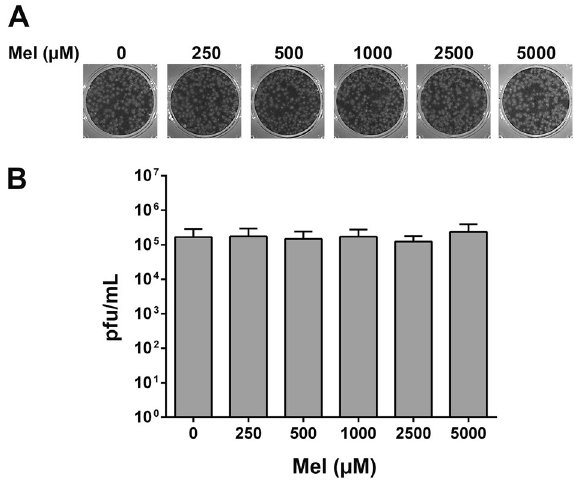
Figure 2. Analysis of the direct virucidal activity of melatonin (Mel) against Japanese encephalitis virus (JEV). ( A ) JEV was incubated with melatonin at various concentrations for 2 h, and the viral titer was determined by plaque assay and expressed in pfu/mL. ( B ) Representative plaque formation assay result. The graph shows the means ± SD of three independent experiments in technical triplicate. One-way ANOVA and Tukey–Kramer multiple comparisons tests were performed, and no statistical significance was